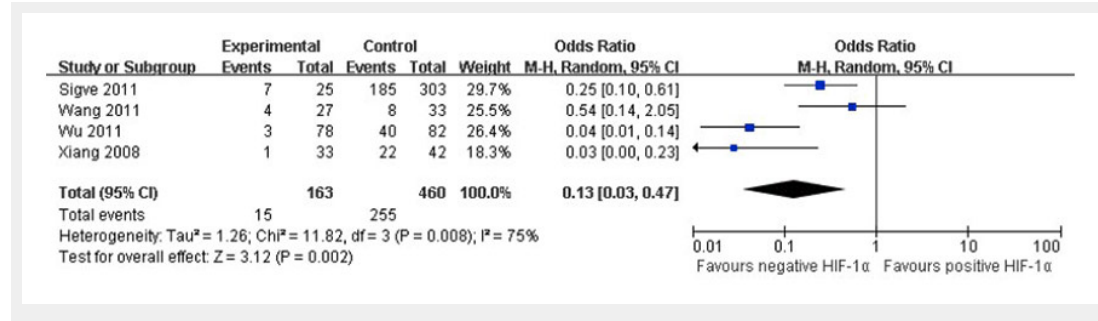
Figure 4 Forest plot of association between HIF-1α expression and 5-year survival rates.